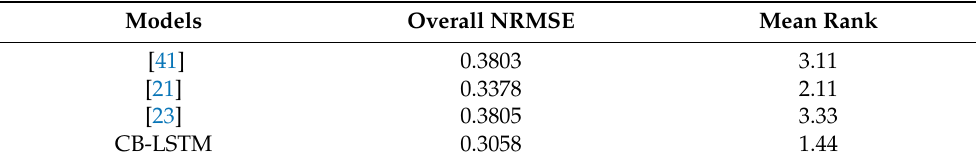
Table 9. Overall forecasting performance of CB-LSTM compared to that of